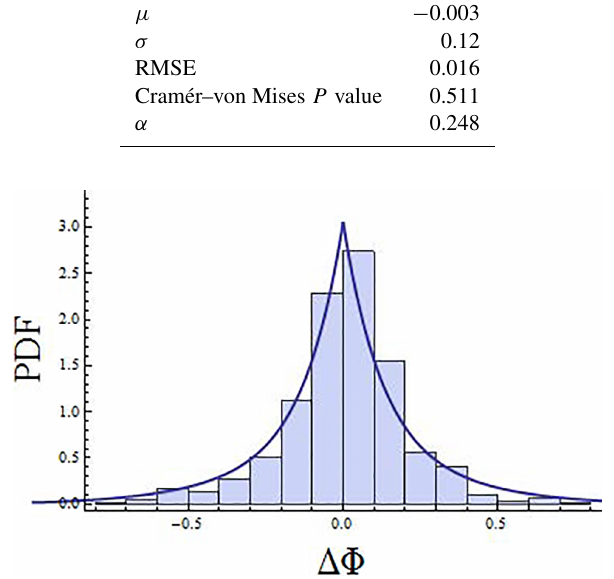
Figure 9. Histogram with bin width of 10 (cid:48) ; the blue continuous curve is the statistical distribution inferred for Riccioli’s set.